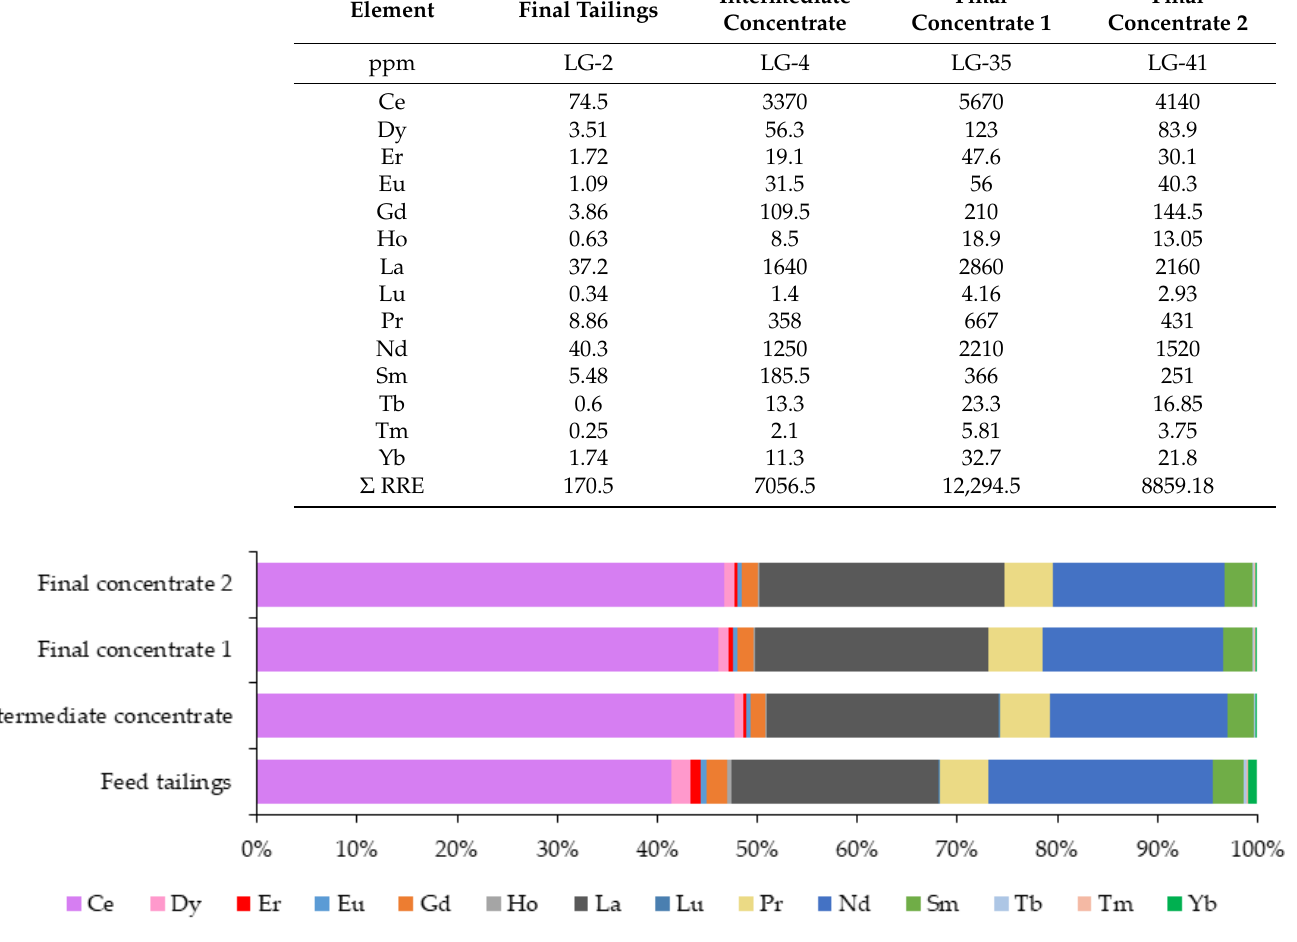
Figure 4. Ratios among the REE contents in the feed tailings and in the processing plant products.